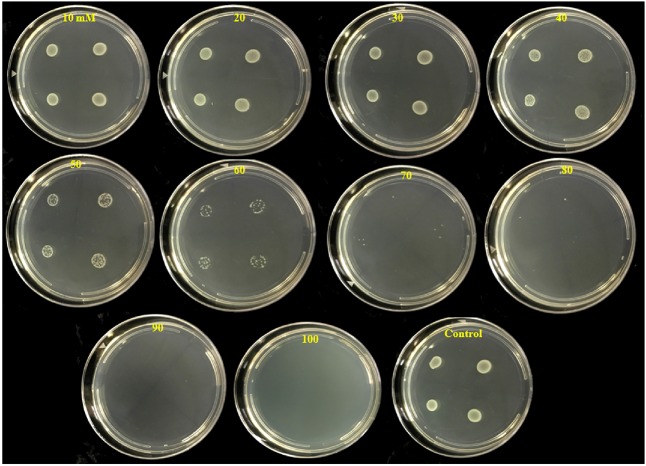
Inhibition of colony development of P. carotovorum by increasing concentrations of potassium tetraborate tetrahydrate (PTB). Aliquots (10 μl) containing 107 CFU of P. carotovorum were deposited at four sites on a series of Petri plates which contained different concentrations ranging from 10 to 100 mM PTB. Two colonies developed on plates containing 80 mM, one colony was visible on the plates containing 90 mM and no colonies developed on plates containing 100 mM PTB.